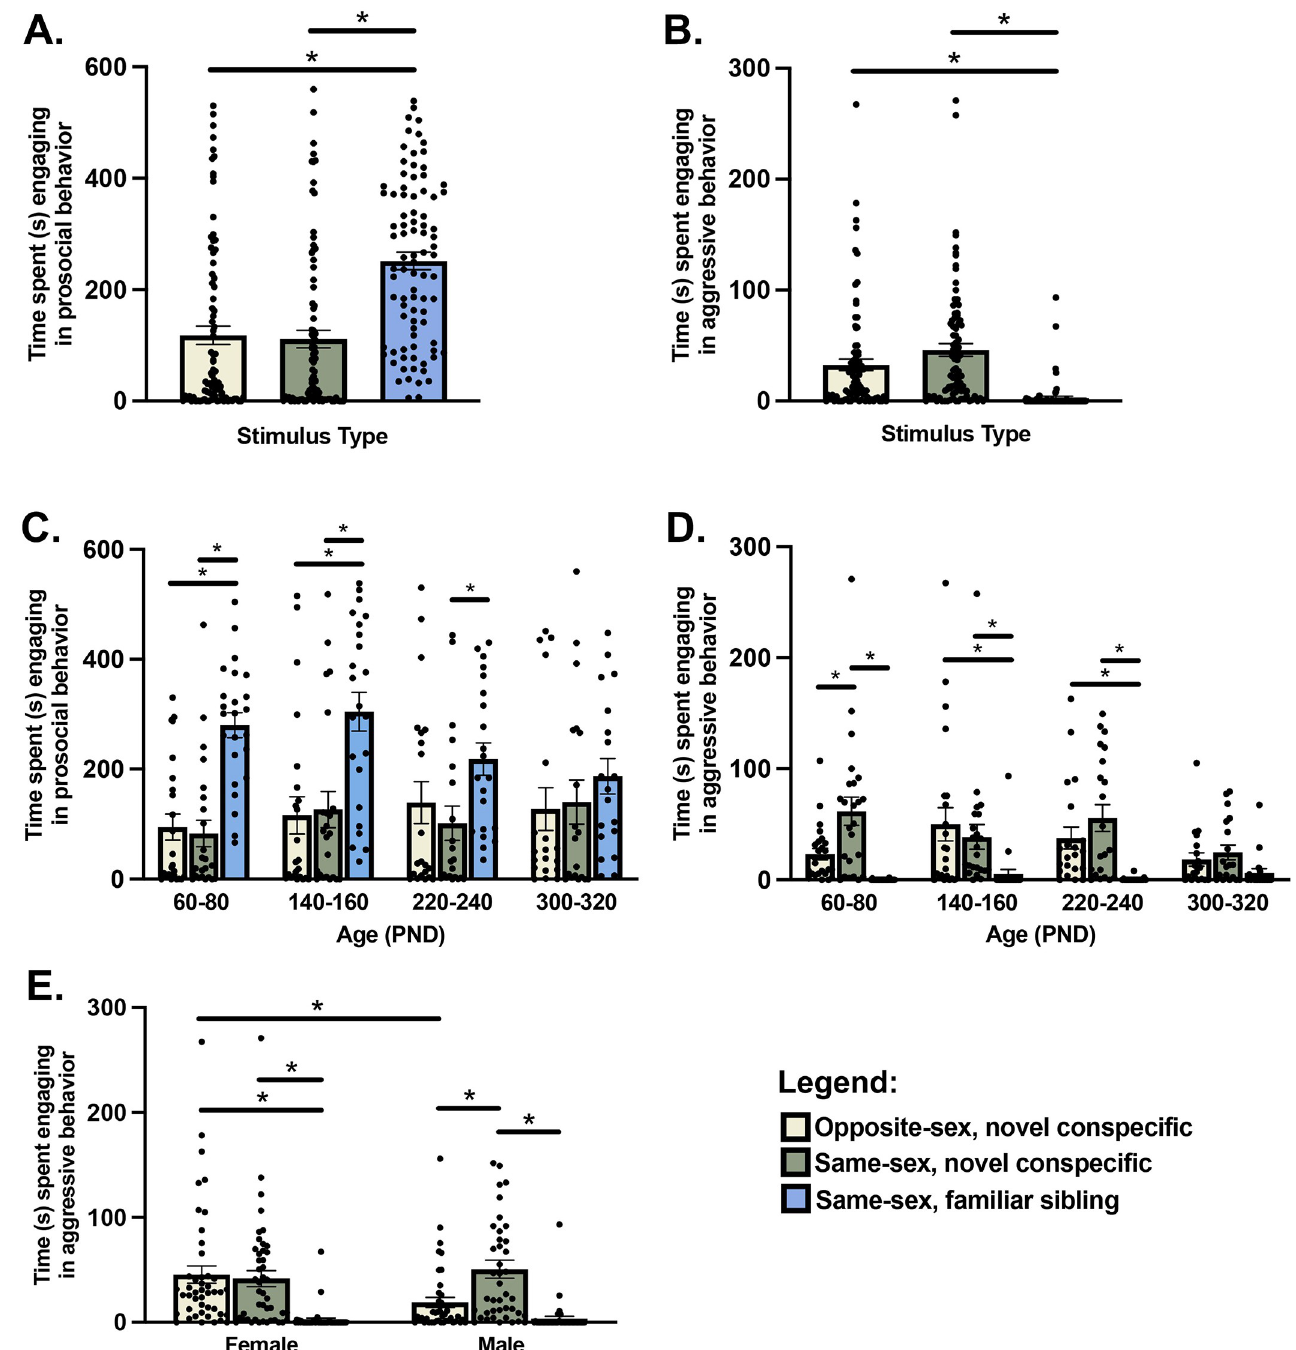
Fig 3. Mean ± SEM time (seconds, s) spent engaging in prosocial behavior and aggressive behavior in a social interaction test with a novel opposite-sex conspecific (beige), novel same-sex conspecific (green), and familiar same-sex sibling (blue). Male and female voles were (A) more prosocial and (B) less aggressive with their siblings compared to other stimulus types. (C) Prosocial behavior and (D) aggression varied by the type of conspecific voles interacted with for all age groups except the eldest group, PND300-320. (C) Aggression differentially varied by the type of conspecific males and females interacted with; females were more aggressive in interactions with opposite-sex conspecifics compared to males. Dots represent individual data points. � indicate statistical significance.